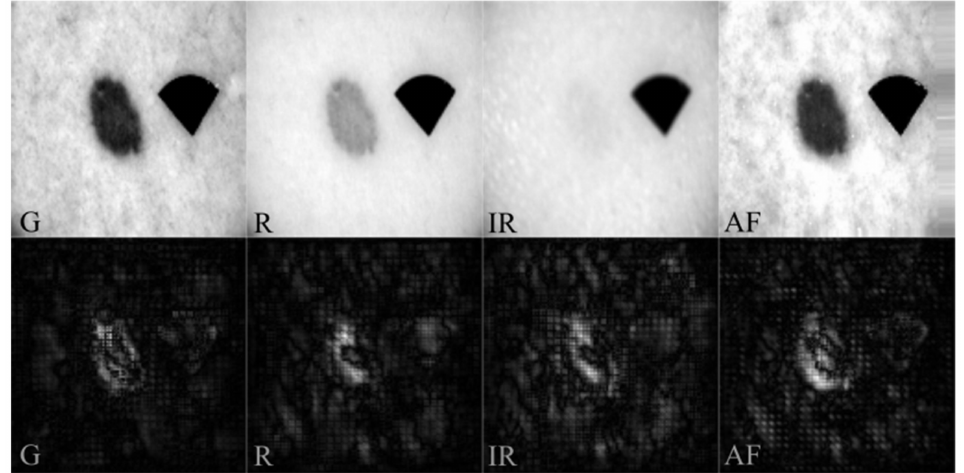
Figure 4. Input multispectral G, R, IR, and AF images ( top row) and corresponding saliency maps ( bottom row). PBL input images were recognized as PBL (classification of MLL vs. PBL vs. HKL vs. NMSC vs.